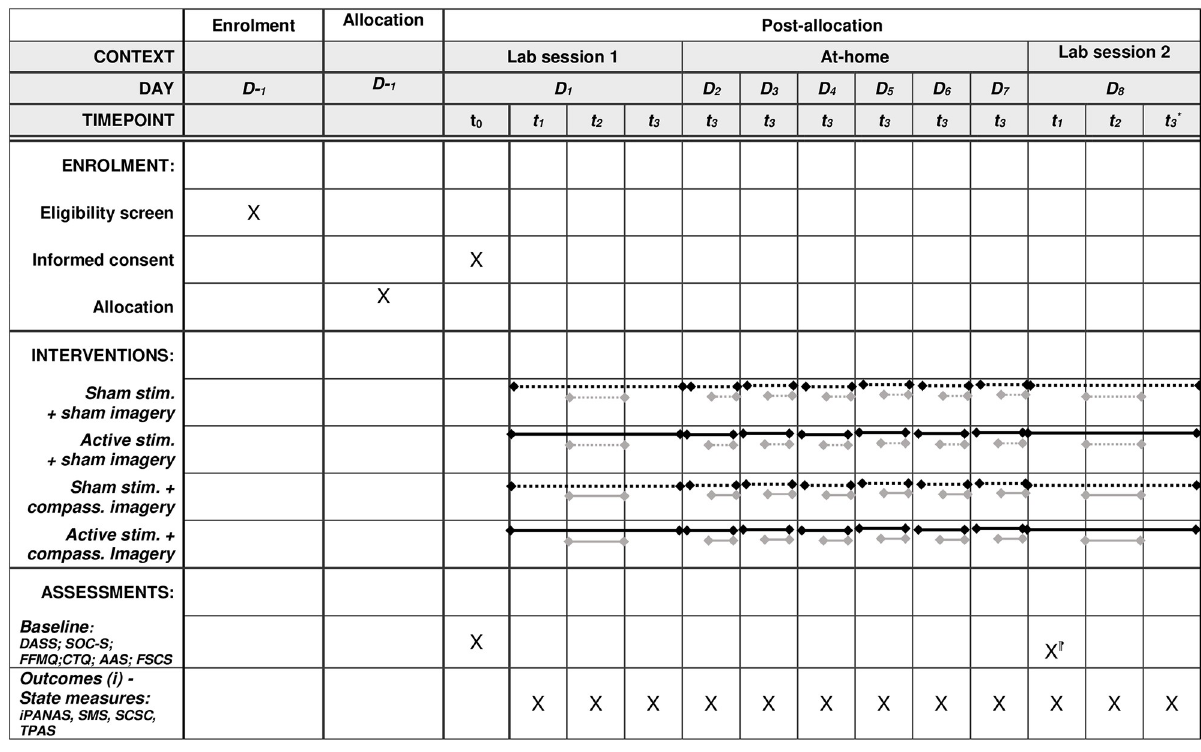
Fig 1. Standard protocol items: Recommendations for Interventional Trials (SPIRIT) schedule of enrolment, interventions, and assessments.